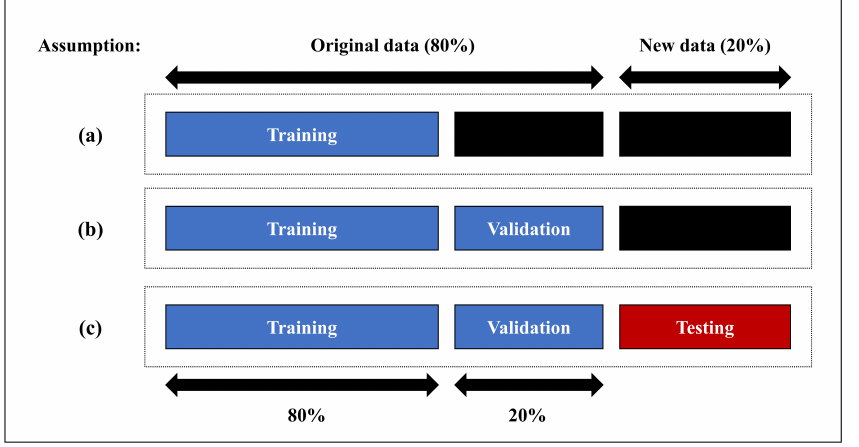
Figure 2. Dataset divided for experimental